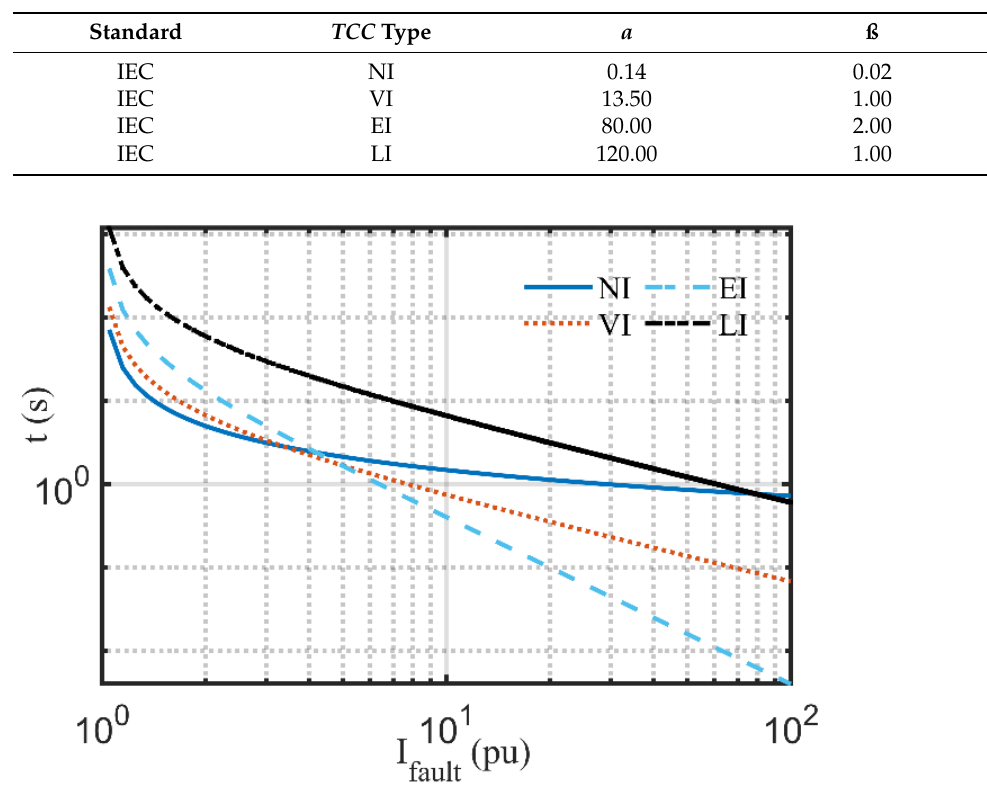
Table 1. Constant values for various IEC standard curves.